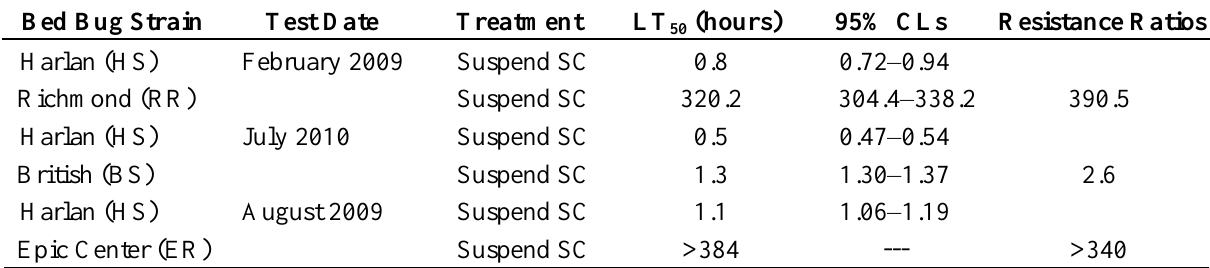
Table 1. LT values (% hours) calculated for adult bed bugs (50% male: 50% female) 50 confined on hardboard panels treated with residual insecticide [27]. Field samples were run same day with Harlan (HS) samples for